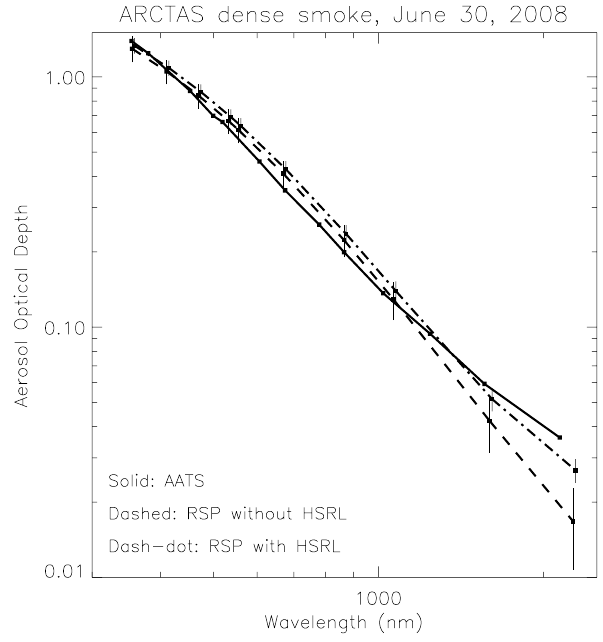
Fig. 4. Here we compare spectrally dependent aerosol optical thick- nesses for AATS (solid) and RSP retrievals with and without HSRL data (dash-dot and dashed, respectively). Values are the geometric mean over the time and space shown in Fig. 3. Vertical lines indicate one standard deviation of the retrieval values in the region shown in Fig. 3, and have been offset with respect to the x-axis slightly to ease visibility. ˚Angstr¨om exponents calculated within the 400nm– 1000nm range are α =2.35for RSP retrievals without HSRL data, α =2.53 for RSP retrievals with HSRL data, and α =2.11 for